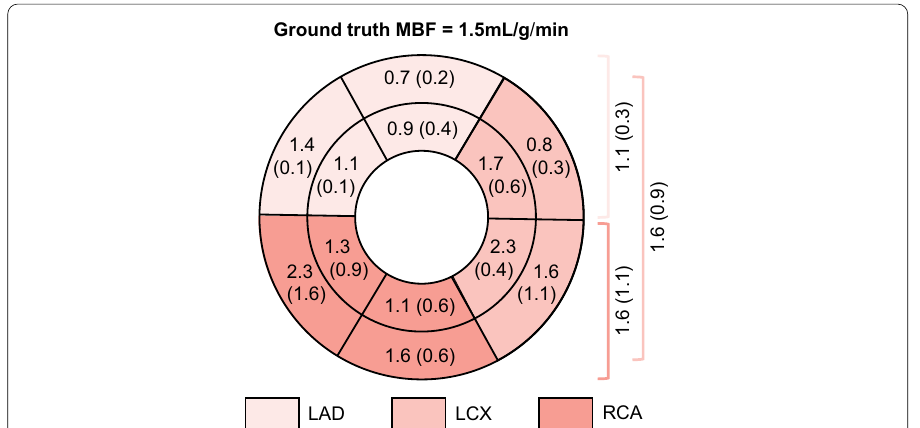
Fig. 6 Preliminary results of computed MBF by clinical software (presented in polar map) compared to ground-truth phantom flow measurement. The presented mean values and standard deviations (SDs) are in mL/g/min. The inner segments of the plot are left blank as the phantom does not mimic the apex. On the right, the mean MBF estimates and SDs are listed for the mimicked regions supplied by the left anterior descending coronary artery (LAD), the left circumflex coronary artery (LCX) and right coronary artery